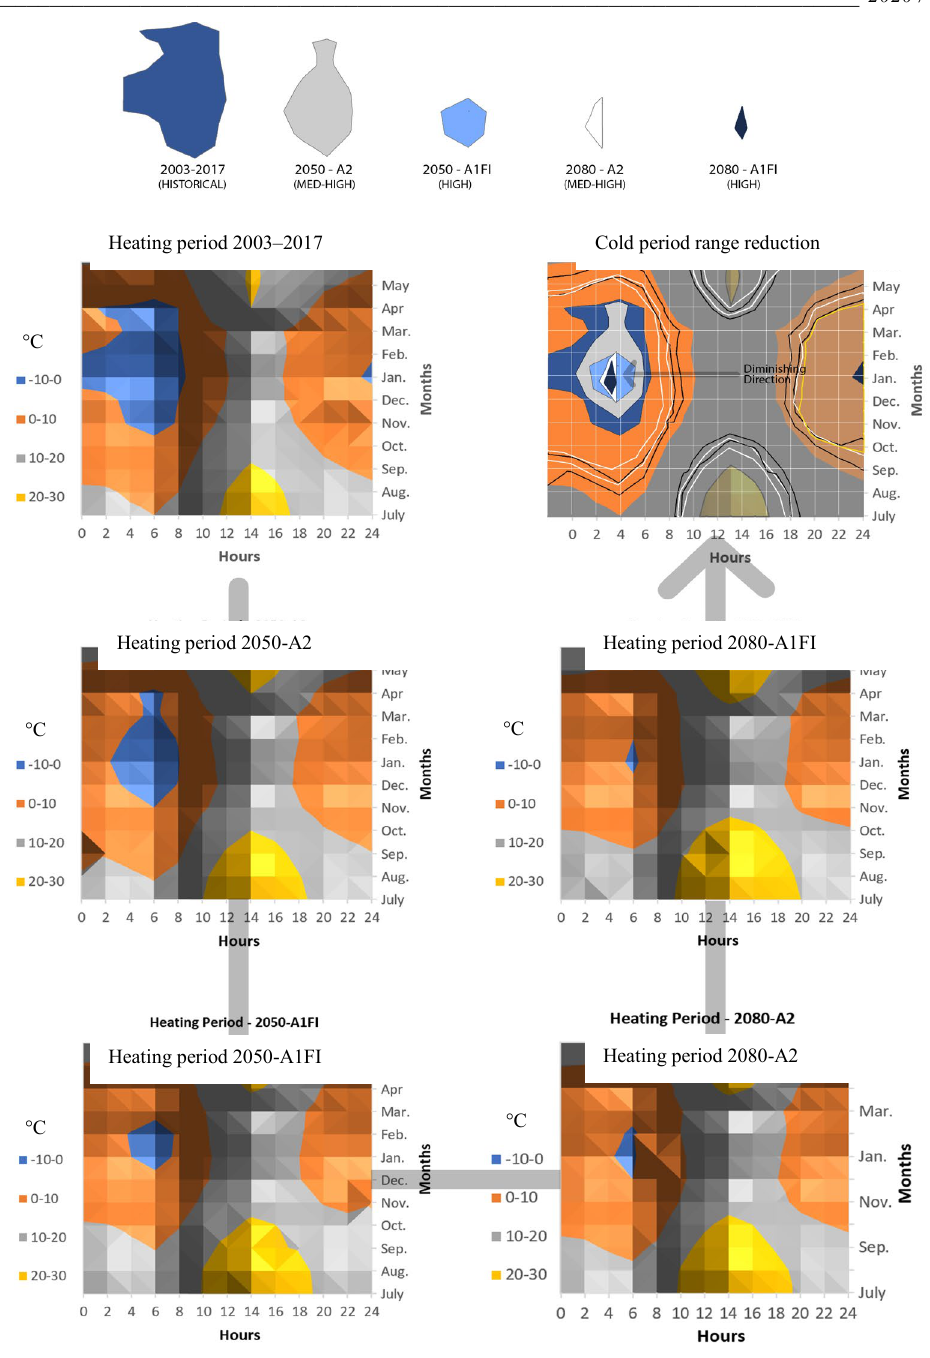
Fig. 5. Heating Periods Sets and